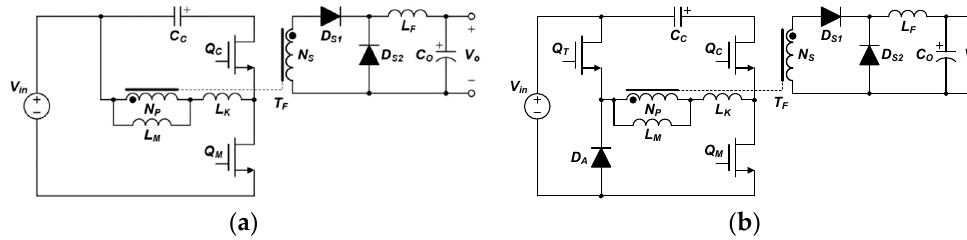
Figure 1. ( a ) Conventional active ‐ clamp forward converter; ( b ) three ‐ switch active ‐ clamp forward converter.